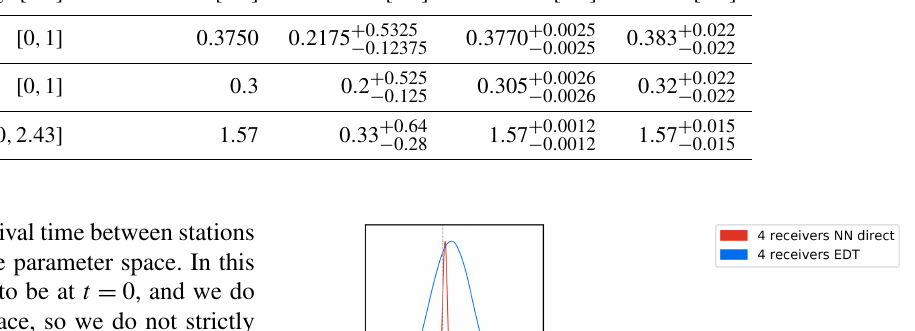
Table 2. Prior range and mean and marginalized 68% credibility intervals on the coordinates ( x,y,z ) for the D18 method, our proposed NN direct model described in Sect. 2.2.1, and the EDT time arrival inversion described in Sect. 3.3. Coord. Prior range [km] Ground truth [km] D18 [km] NN direct [km] EDT [km] x [ 0 , 1 ]